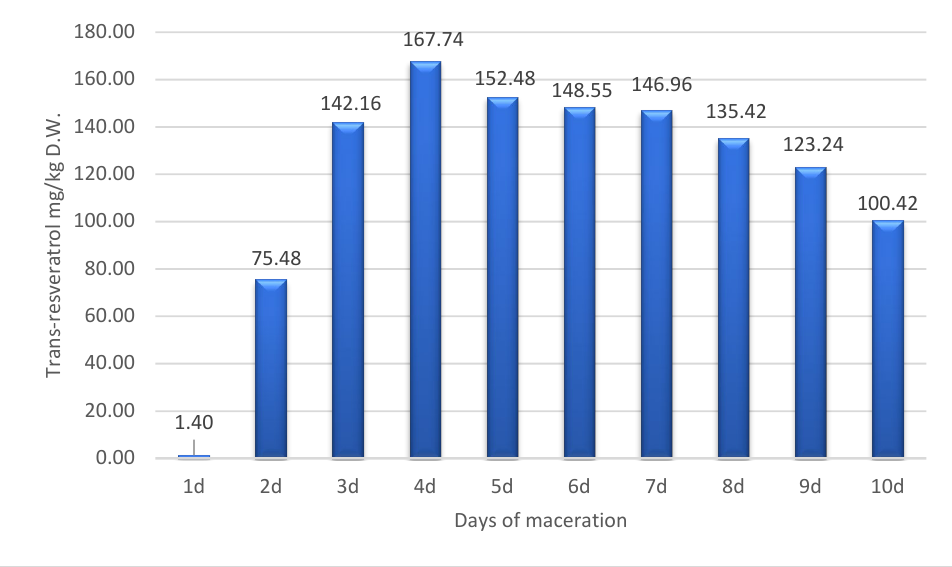
Figure 3. Extraction yield of resveratrol from vine shoots for different time of maceration.